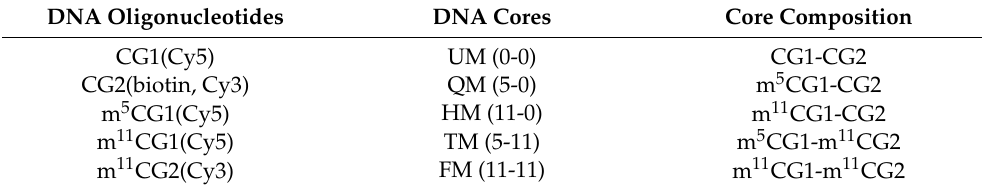
Table 1. DNA oligonucleotides used in this study and types of DNA cores and their compositions. DNA Oligonucleotides DNA Cores Core